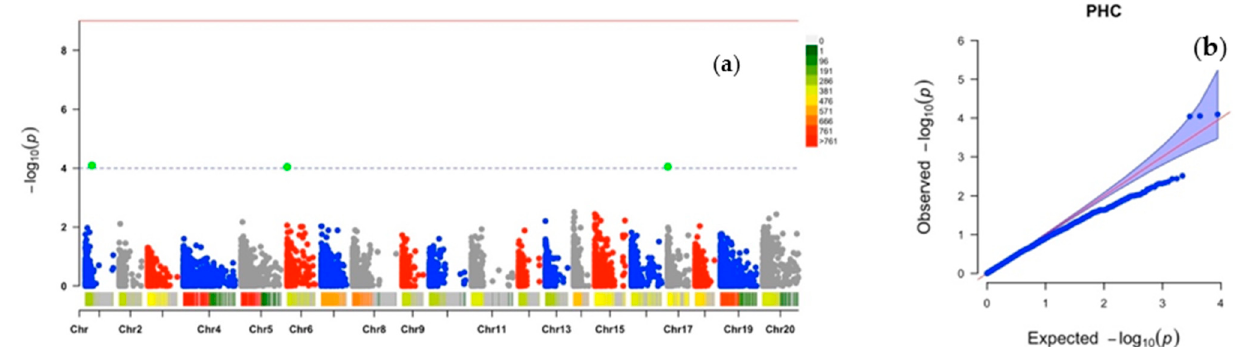
Figure 3. Genome-wide association analysis for percentage high crossability (PHC) in D. alata : ( a ) Manhattan plot, ( b ) quantile–quantile (Q–Q) plot. Vertical bars relate to the 20 yam chromosomes, green dots indicate chromosomes with influence on the target trait.